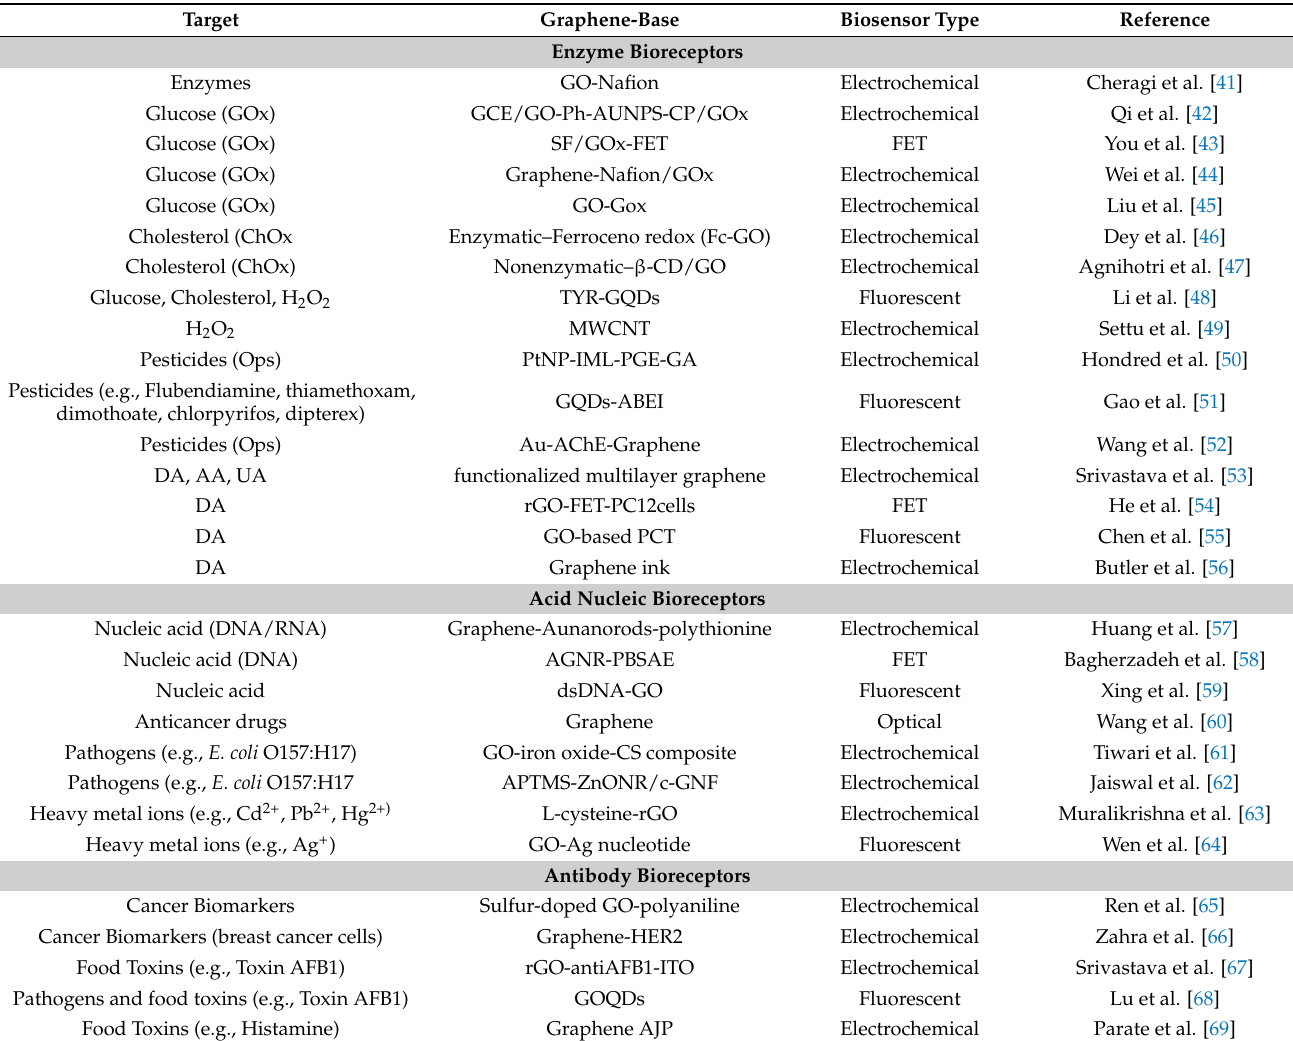
Table 2. Graphene-based biosensors with biomolecules as